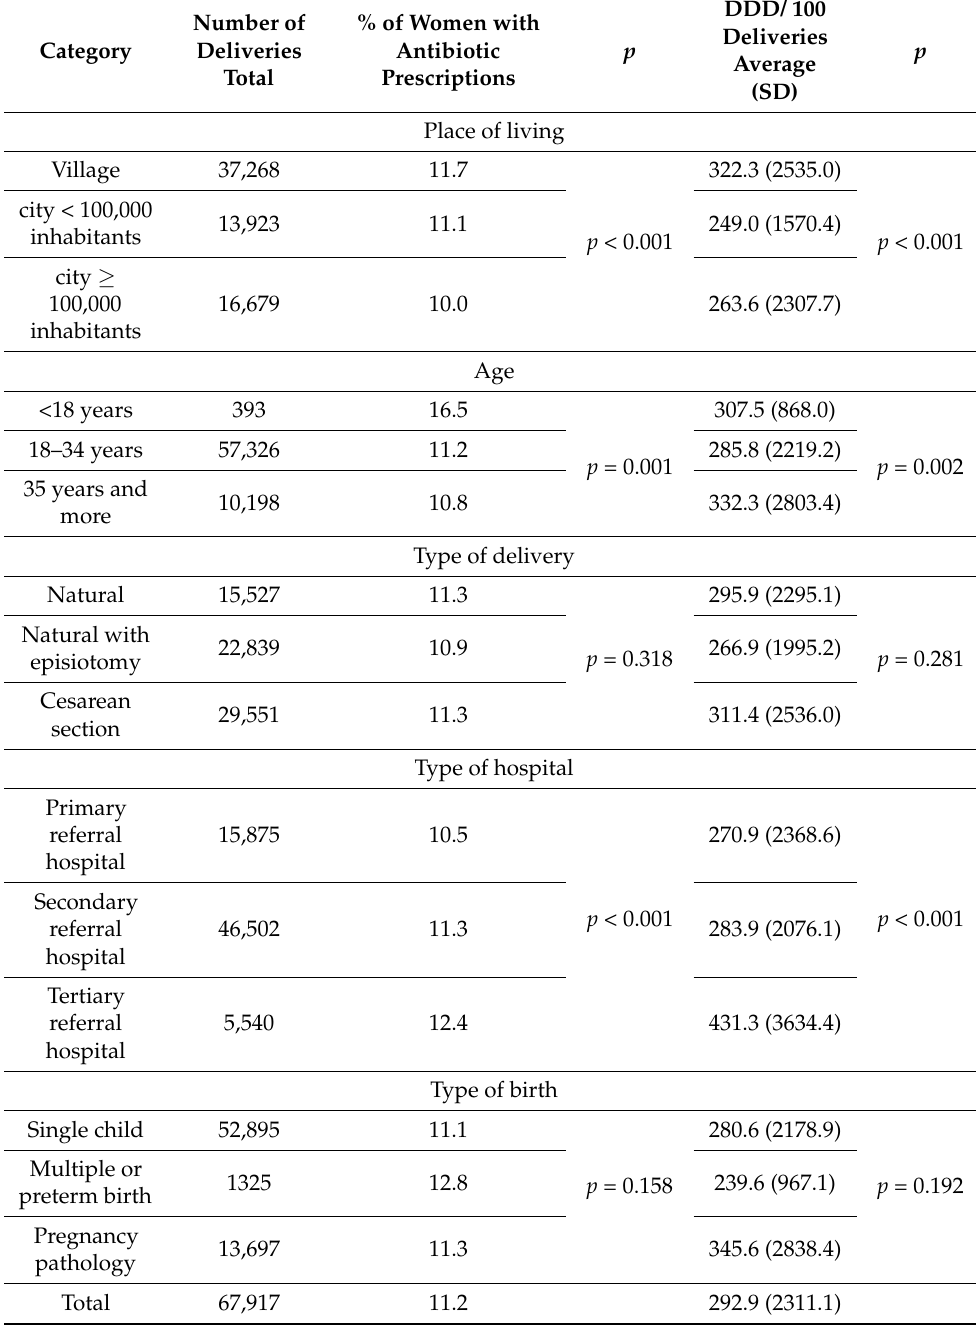
Table 5. Number of prescriptions and DDD for the third trimester according to place of living, hospital type, women’s age, and type of